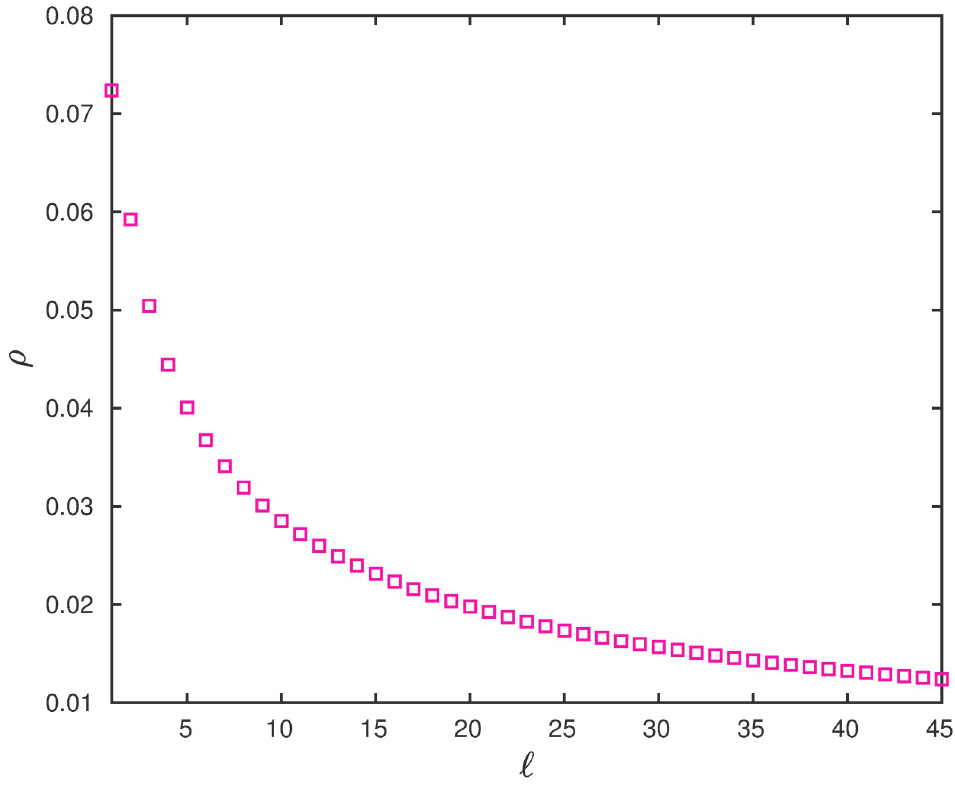
Fig 8. The steady-state mean reader density ρ as a function of ℓ 2 {1, 2, ... , 45} for a EFEIOD with n = 100, λ 0 = 1, λ i = 1, α i = 0, for all i , q = 0.01 and r = 1/ q .